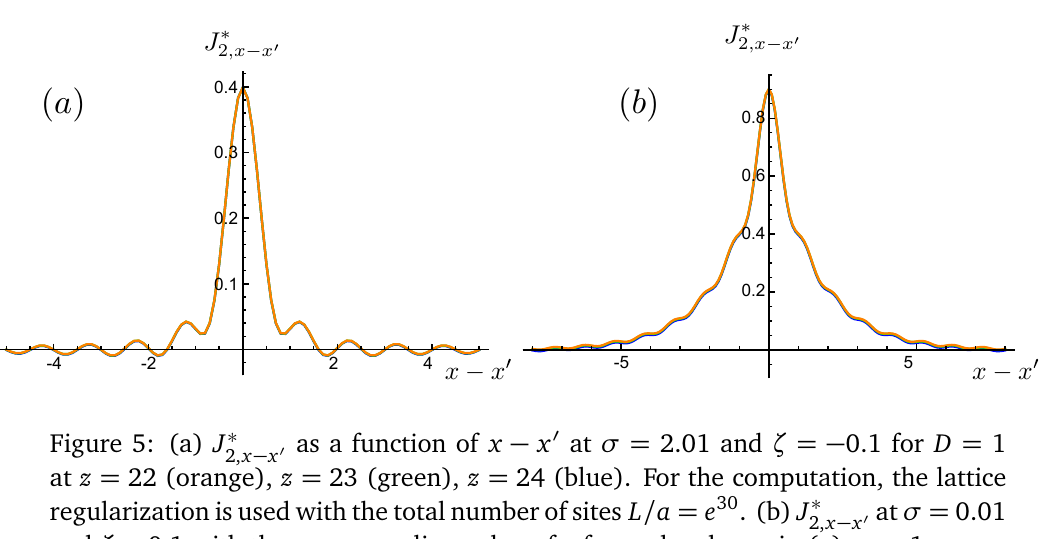
at σ = 0.01 2, x − x (cid:48)